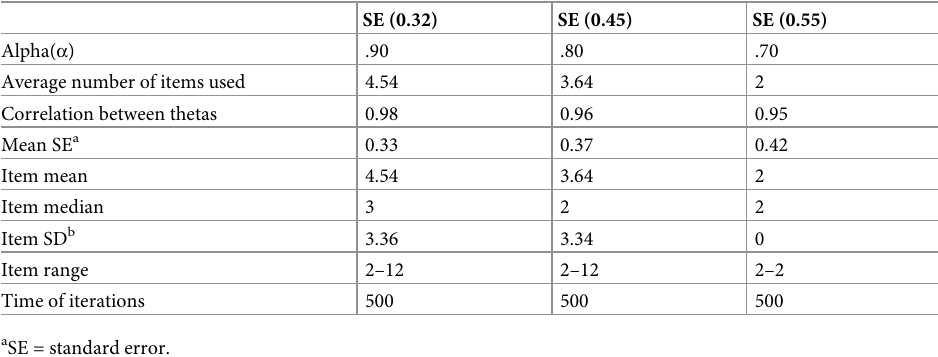
Table 5. Results of three ENRICh CAT simulations with varied